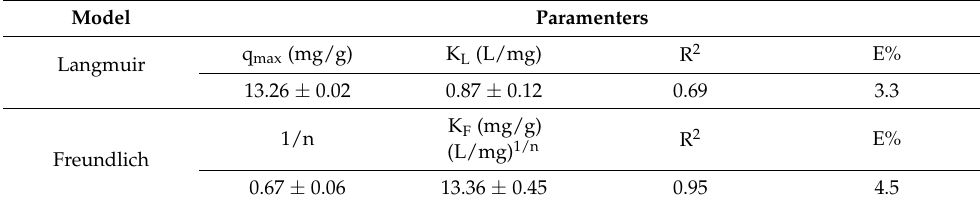
Figure 8. Isotherms for the process of adsorption of MG to polyimide nanofiber. Langmuir model ( a ). Freundlich model ( b ). Using 2.0 mg of adsorbent at 20 °C. Table 1. Parameters for adsorption of malachite green to polyimide